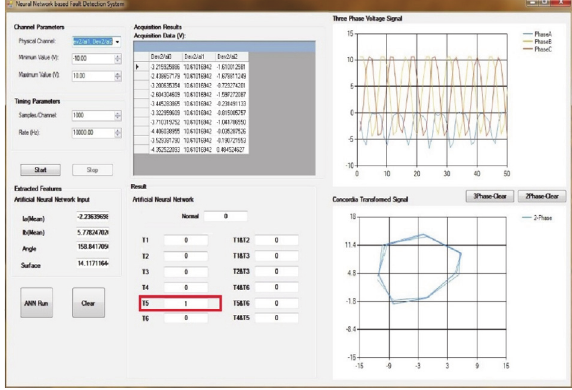
Figure 18: System operating in single fault (T5)